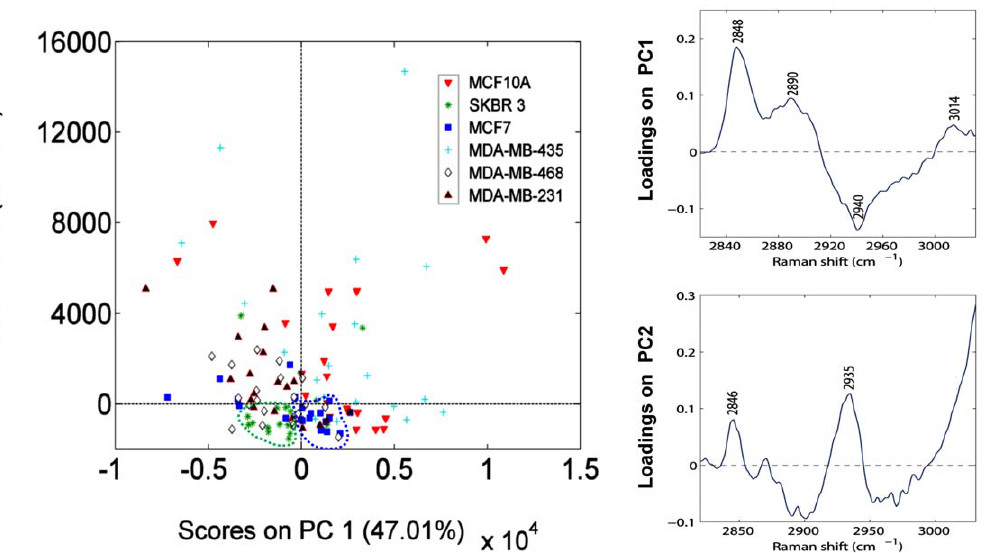
Figure 2. PCA scores showing the cell variability present inside each cell line and between the different cell lines. Illustration of PCA scores from MCF10A, MDA-MB-231, MDA-MB-435, MDA-MB-468, MCF7 and SKBR3 cell lines RS acquisition. SKBR3 cells are shown in the green circle and MCF7 cells in the blue circle. MDA-MB-435 and MCF10A cells are the most dispersed in the plot. On the right, the loading plots for each Principal Component, both related to fatty acid and protein content (TUFA: 3014 cm 2 1 ; protein and lipid: 2940 cm 2 1 ; TFA: 2871, 2890, 2846 and 2848 cm 2 1 ; -CH3: 2935 cm 2 1 ). Percentages in the score plots represent the variance accounted for each PC. doi:10.1371/journal.pone.0046456.g002 We analyzed the cholesterol content of the cell lines using filipin respectively, showing good stability for predicting new samples. A good discrimination between metastatic and non-metastatic cell staining, which labels free (unesterified) cholesterol present in the lines was achieved with sensitivities and specificities of 92.5% and cytosol and membranes of cells. We found differences in the 97.4% for the calibration and 90% and 82.1% for the cross- content and distribution of free cholesterol between the cell lines. validation respectively. These results showed good accuracy in